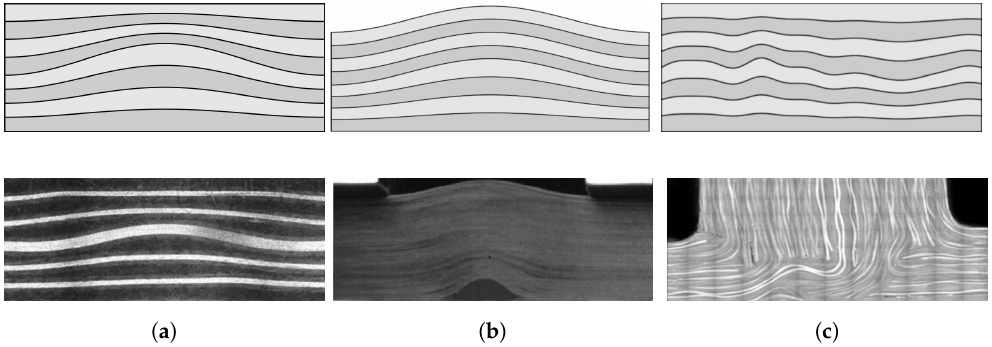
Figure 1. Two-dimensional examples of out-of-plane fiber waviness in a composite laminate. ( a ) Em- bedded single graded waviness, reprinted with permission from Ref. [5], 2013, S. Mukhopadhyay; ( b ) hump, reprinted with permission from Ref. [6], 2012, P. Davidson; ( c ) complex stochastic dis- tributed waviness, reprinted with permission from Ref. [7], 2010, R.